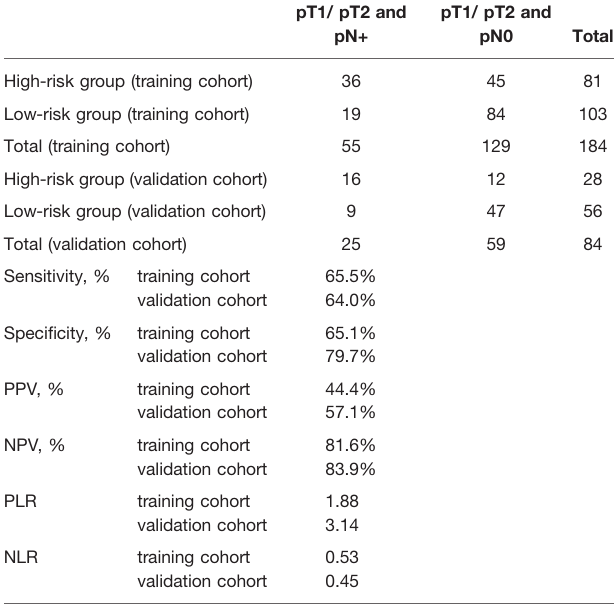
TABLE 6 | The accuracy of nomogram in T1/T2 staging of ESCC.